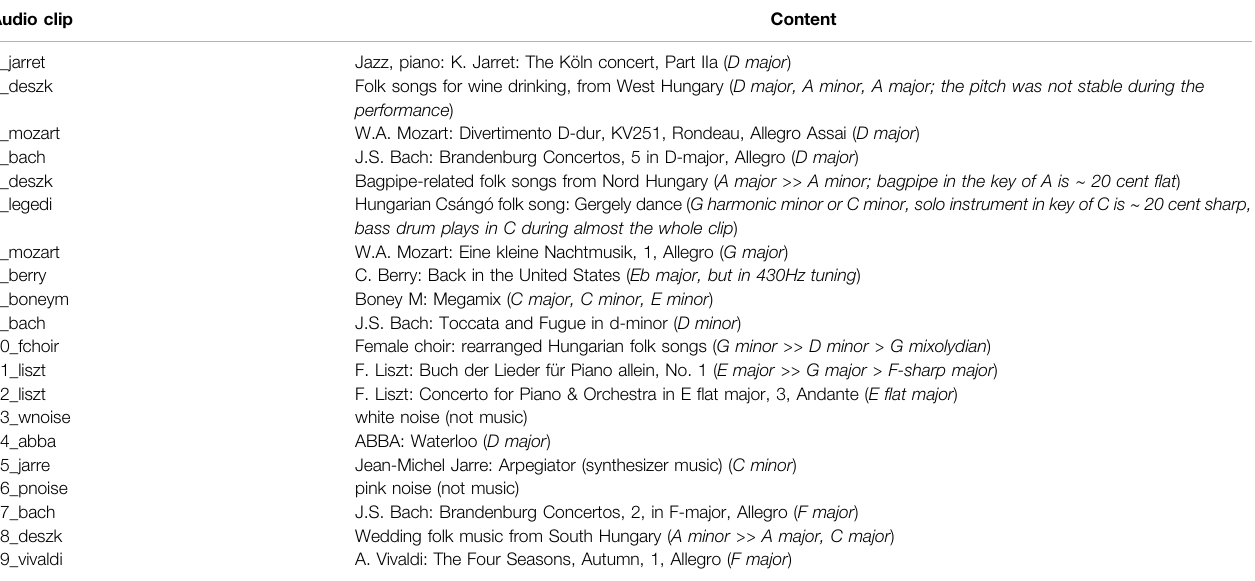
TABLE1| Thecontentoftheaudioclips a playedtotheV-ATPaseasoscillatingelectric fi eld,sortedfrommaximumenhancement(top)tomaximumreduction(bottom)ofthe speci fi c activity of the